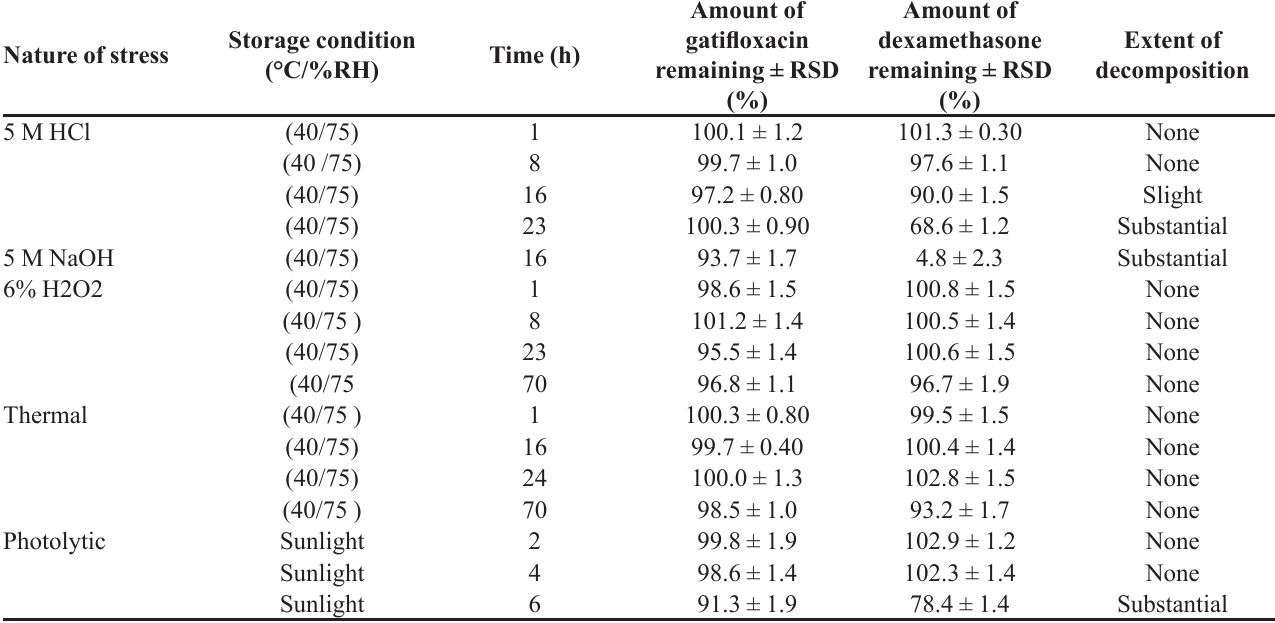
TABLE V - Stress testing results of gatifloxacin and dexamethasone